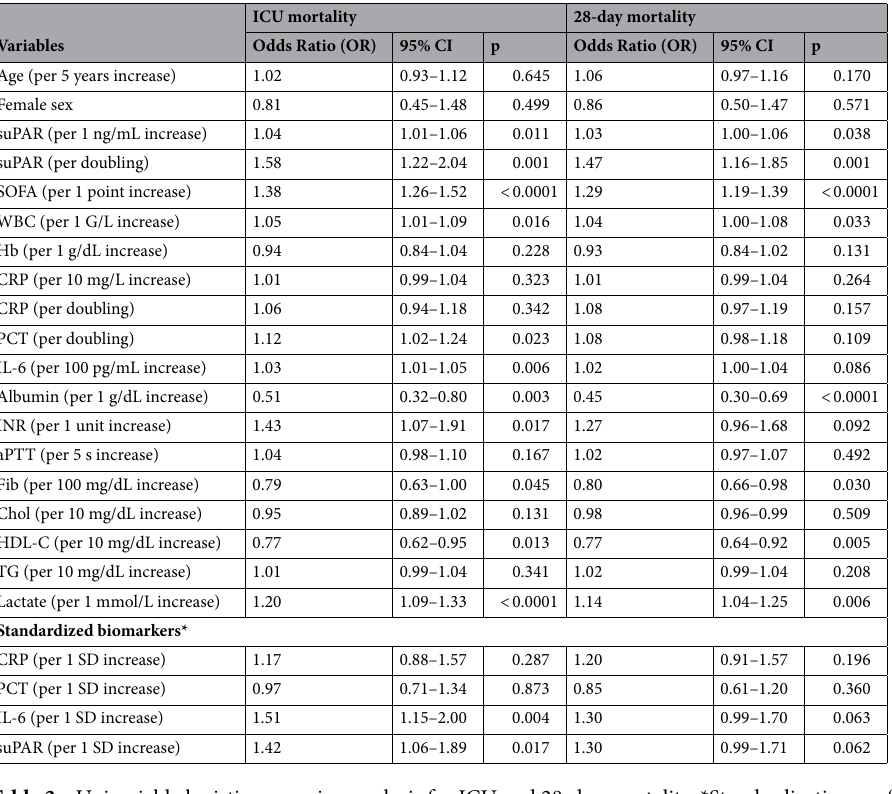
Table 3. Univariable logistic regression analysis for ICU and 28-day mortality. *Standardization performed for those n = 215 patients who had all 4 biomarkers observed. Abbreviations: ICU = intensive care unit; CI = confidence interval; suPAR = soluble urokinase plasminogen activator receptor; SOFA = sequential organ failure assessment; WBC = white blood count; Hb = hemoglobin; CRP = C-reactive protein; PCT = procalcitonin; IL-6 = interleukin-6; INR = international normalized ratio; aPTT = activated partial thromboplastin time; Fib = fibrinogen; Chol = Cholesterol; HDL-C = high-density lipoprotein cholesterol; TG = triglycerides; SD = standard deviation.